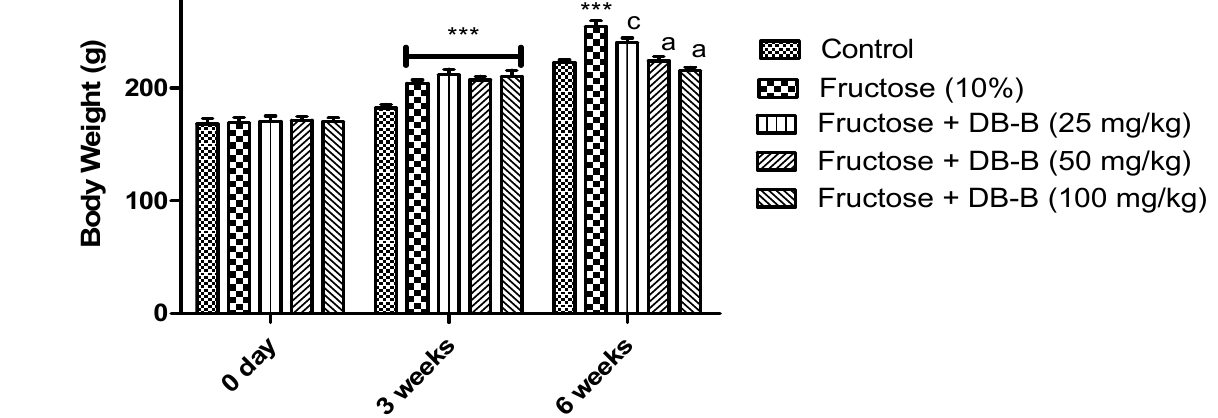
Figure 2. DB-B-evoked decrease in sympathetic activity in fructose hypertensive rats. All results were analyzed statistically using two-way ANOVA followed by the Bonferrani test using GraphPad Prism. Data is presented as mean ± SEM and *** p < 0.001 in relation to the control group, whereas a = p < 0.001 in comparison with the fructose-treated group. 2.3. DB-B-Prevented Increase in Body Weight in Fructose-Fed Rats Chronic administration of fructose (10%) increased the body weight of the disease control group. The treatment showed a reduction in body weight as compared with the disease control group (Figure 3).